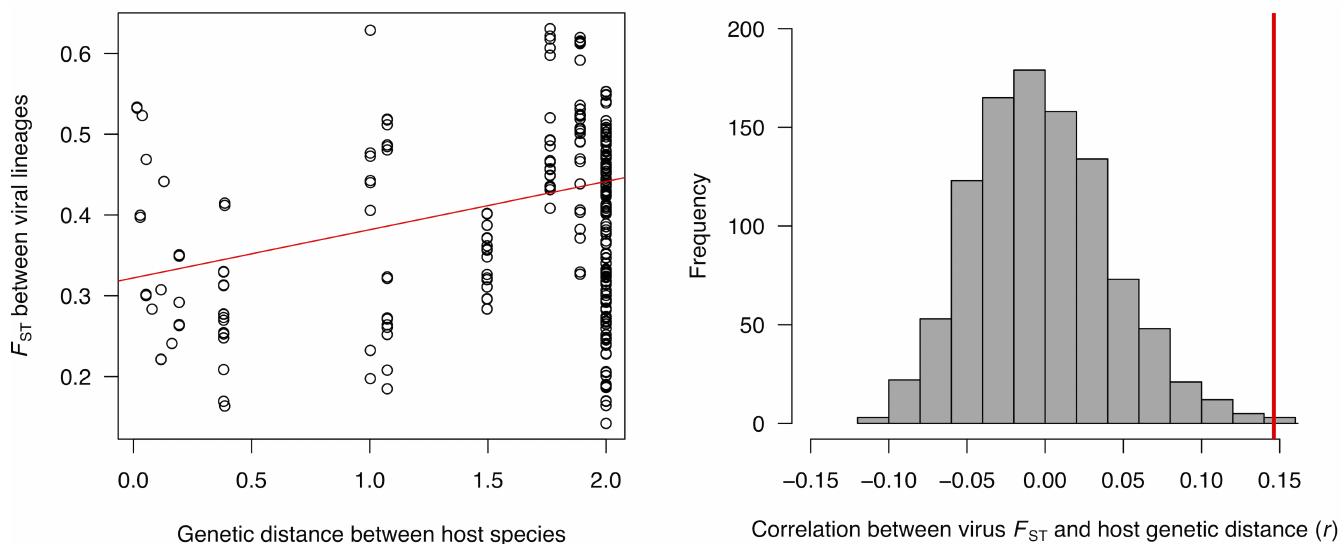
Fig 3. Viral lineages from more closely related host species are genetically more similar. (A) The correlation between the genetic differentiation of viral lineages and the genetic distance between the species they have evolved in. Linear regression line is shown in red. Genetic distances were scaled so that the distance from the root to the tip of the tree was one. (B) Pearson’s correlation coefficient ( r ) of F between pairs of viral lineage and the genetic distance between the host species they evolved in. ST The observed value is in red and the grey bars are the null distribution obtained by